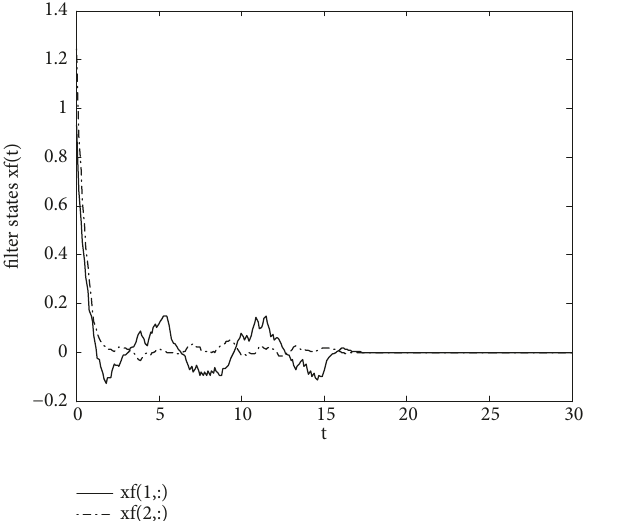
Figure 9: The response curve of vector 𝑒( t )